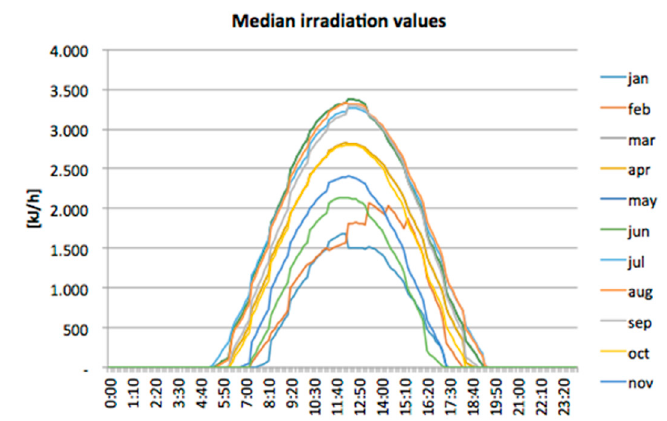
Figure 5. Analysis of specific horizontal irradiation values on Lampedusa Island, Italy (35°30 ′ 56 ″ north (N)).